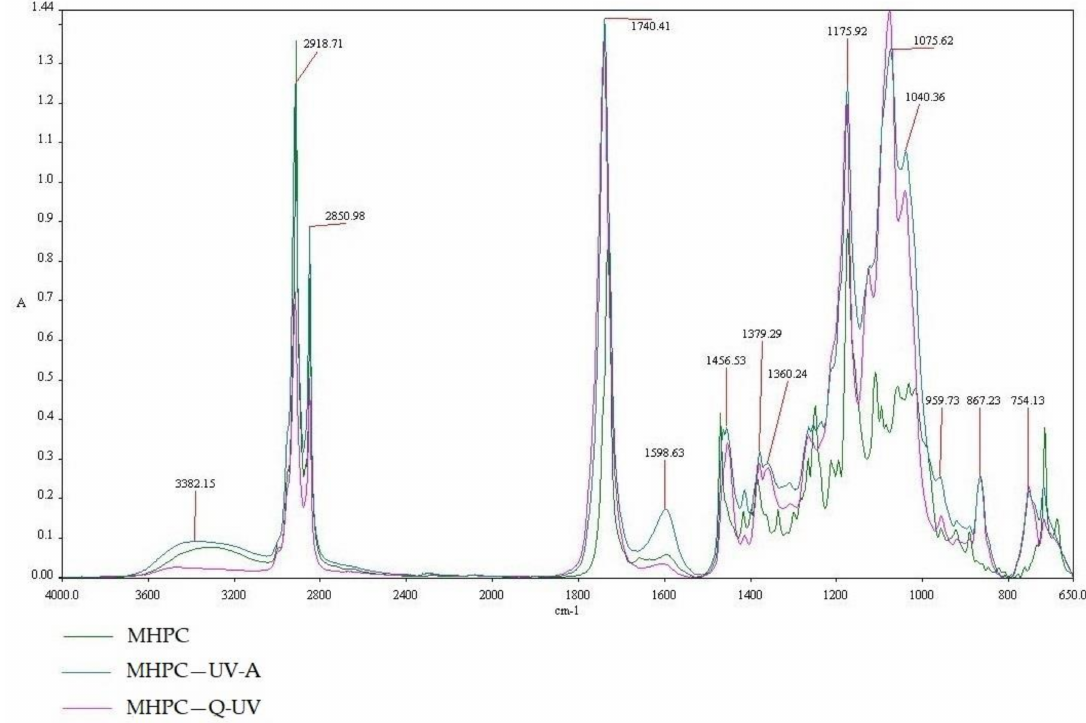
Figure 5. The FT-IR spectra of MHPC, MHPC—UV-A,